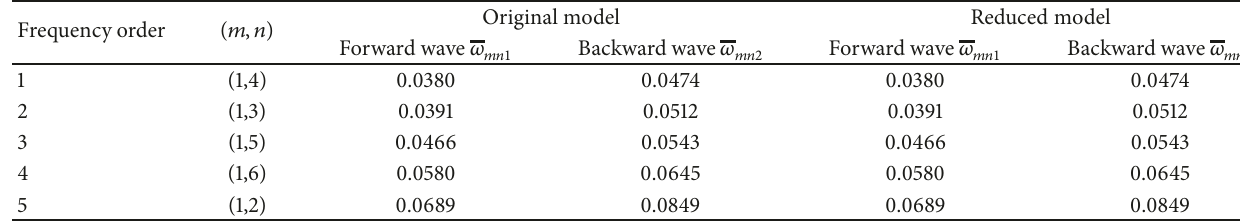
Table 4: Nondimensional frequency parameters of original model and reduced model ( Ω = 0.01